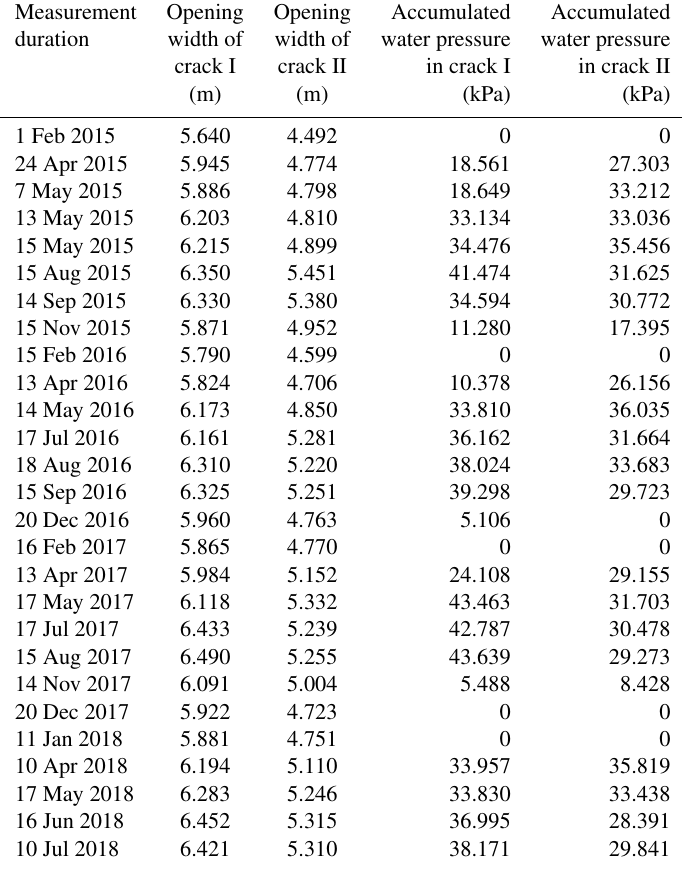
Table 1. Monitoring data of the Wobaoshi landslide.